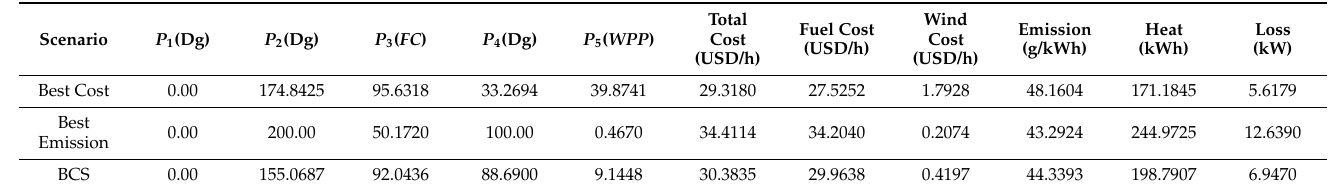
Table 5. Generation schedule and comparative results for SCHPEED with REI with demands of 338 kW.